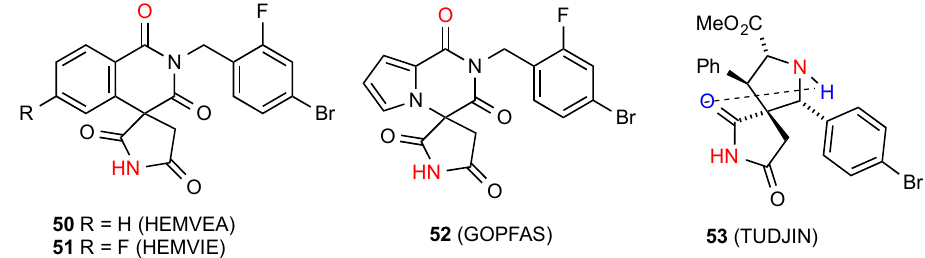
Figure 19. 3,3-Disubstituted succinimides with patterns E and